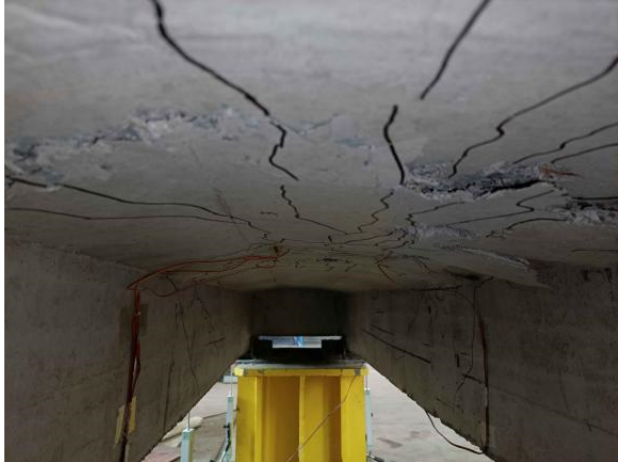
Figure 16. The fatigue damage mode at the slab bottom of P2.